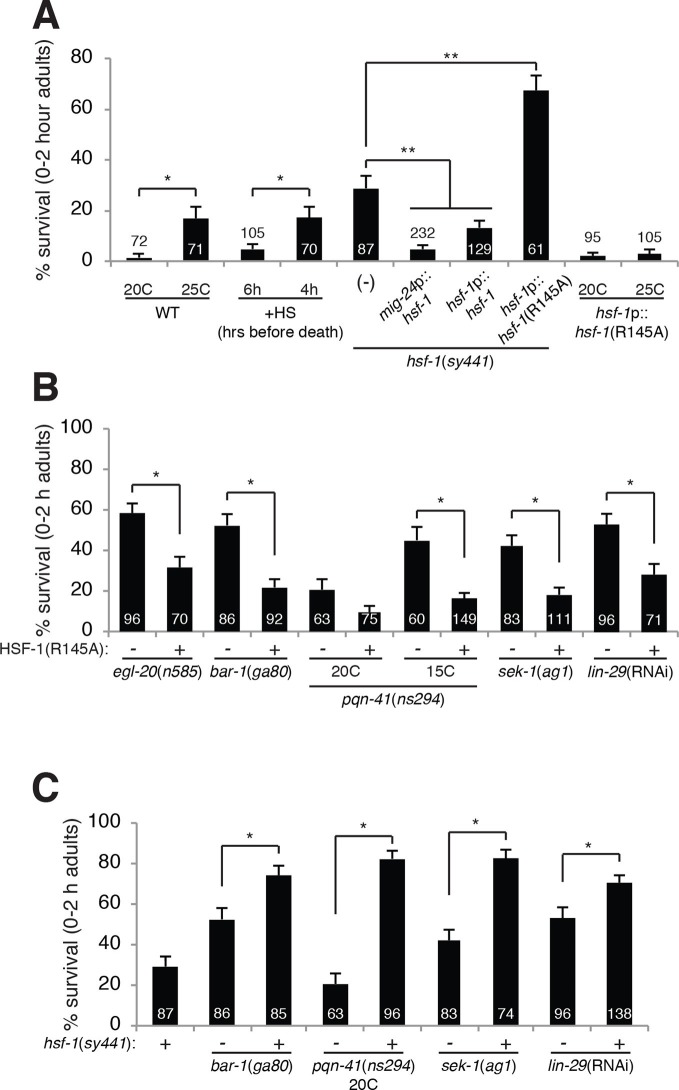
HSF-1 promotes linker cell death.(A) Linker cell survival in indicated genotypes. In
(A-C), strains also contain qIs56 and
him-5(e1490).
*p<10–2;**p<10–3; Fisher’s exact test.
hsf-1p::hsf-1(WT/R145A) transgenes
are fused to GFP. WT: animals raised at indicated temperature after
hatching. +HS: WT animals heat shocked at 37°C for 15 min at 6 hr or 4 hr
before the L4-adult molt. hsf-1(sy441):
mig-24p::hsf-1 bar is average of three
independent extrachromosomal array lines.
hsf-1p::hsf-1(R145A) bar is average
of two independent single-copy integrated lines.
hsf-1p::hsf-1(R145A): animals were
raised at the indicated temperature after hatching. (B)
Linker cell survival in indicated genotypes. HSF-1(R145),
hsf-1p::hsf-1(R145A). The
drSi28[hsf-1p::hsf-1(R145A)]
transgene was used. For
hsf-1p::hsf-1(R145A);
bar-1(ga80), two other independent single-copy
integrated lines gave similar results. (C) Linker cell
survival in indicated genotypes.